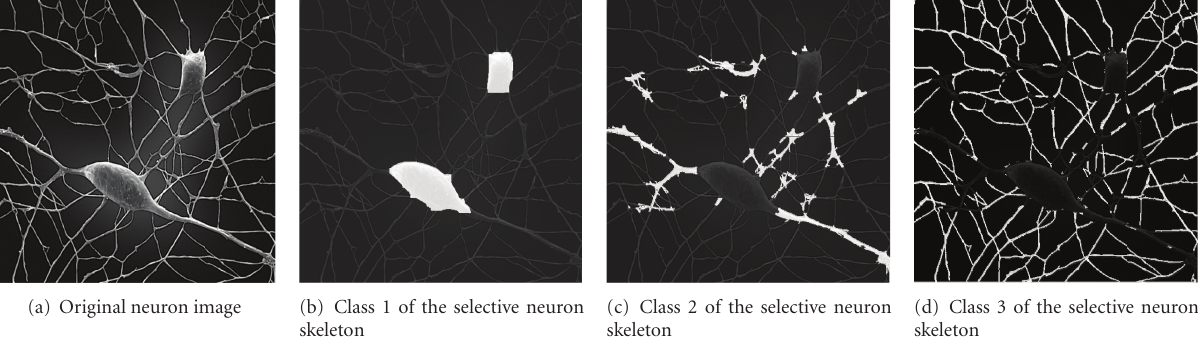
Figure 7: Neuron image classification by using the adaptive PDE